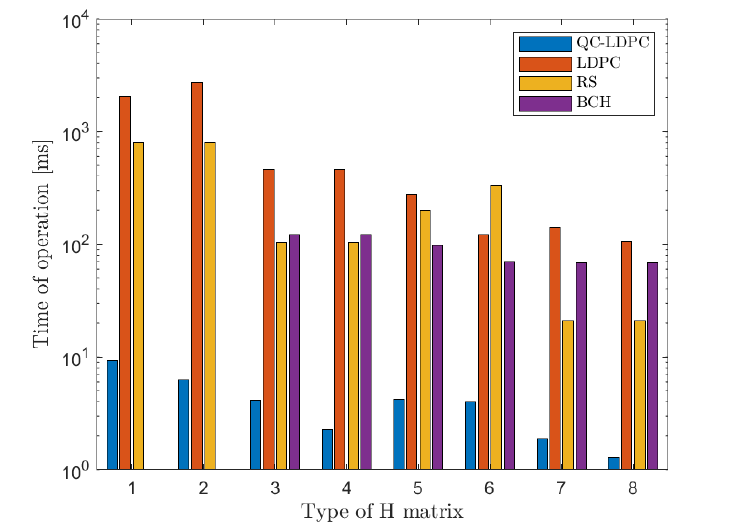
Figure 7. Single block encoding time